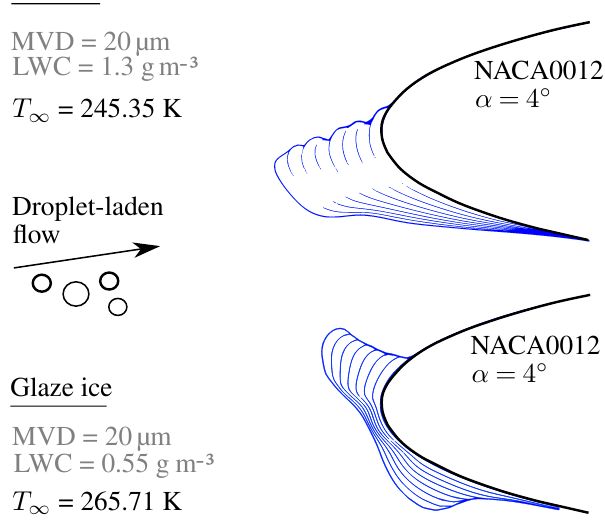
Figure 1. Rime ice and glaze ice shapes over time at the leading edge of a NACA0012 airfoil, chord length 0.53m. One blue line represents one minute of ice accretion. Further boundary conditions (rime): U ∞ = 58ms − 1 , t acc = 8min; (glaze): U ∞ = 102 . 8ms − 1 , t acc = 7min. Data from computations with TAUICE by Jan